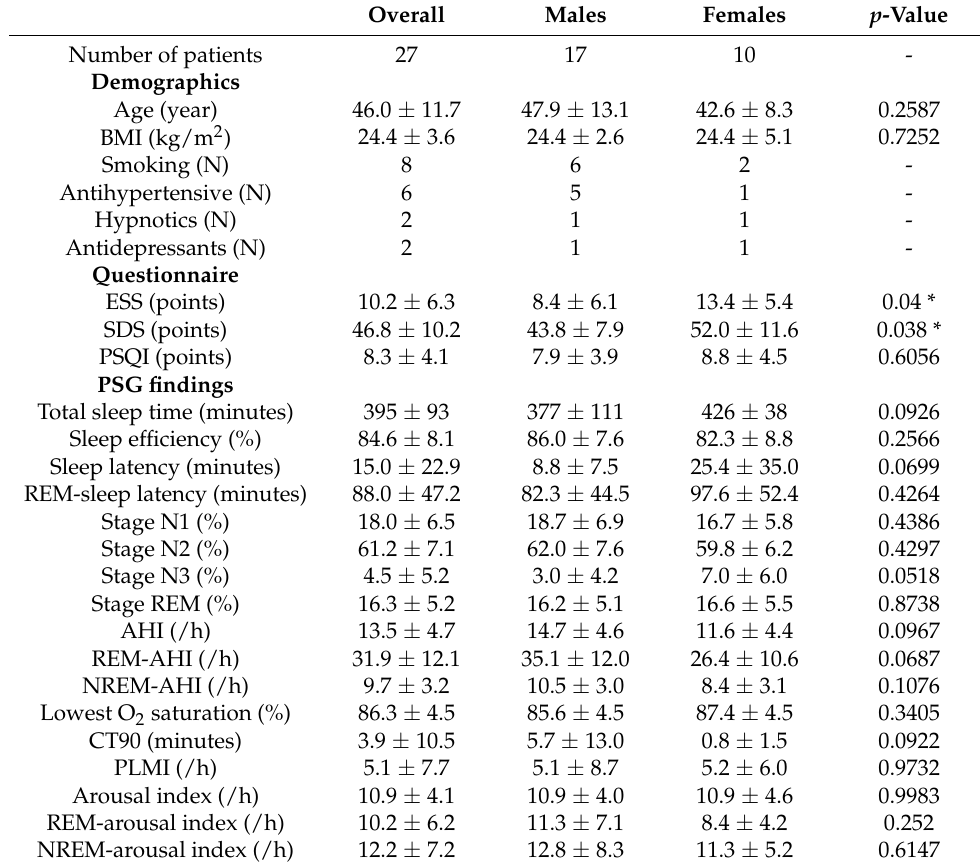
Table 1. Patient demographics, questionnaires, and